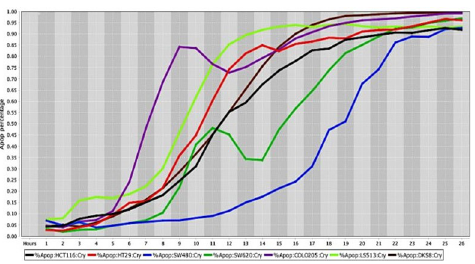
Fig 7. Cell death response curves for human colorectal cancer. Cell death response expressed in percentage of apoptosis in human colorectal cancer cell lines exposed to CT at 20 μ M concentration (HCT116- black line, HT29- red line, SW480- blue line, SW620- dark green line, COLO205—purple line, LS513- neon green line, DSK8- brown line).